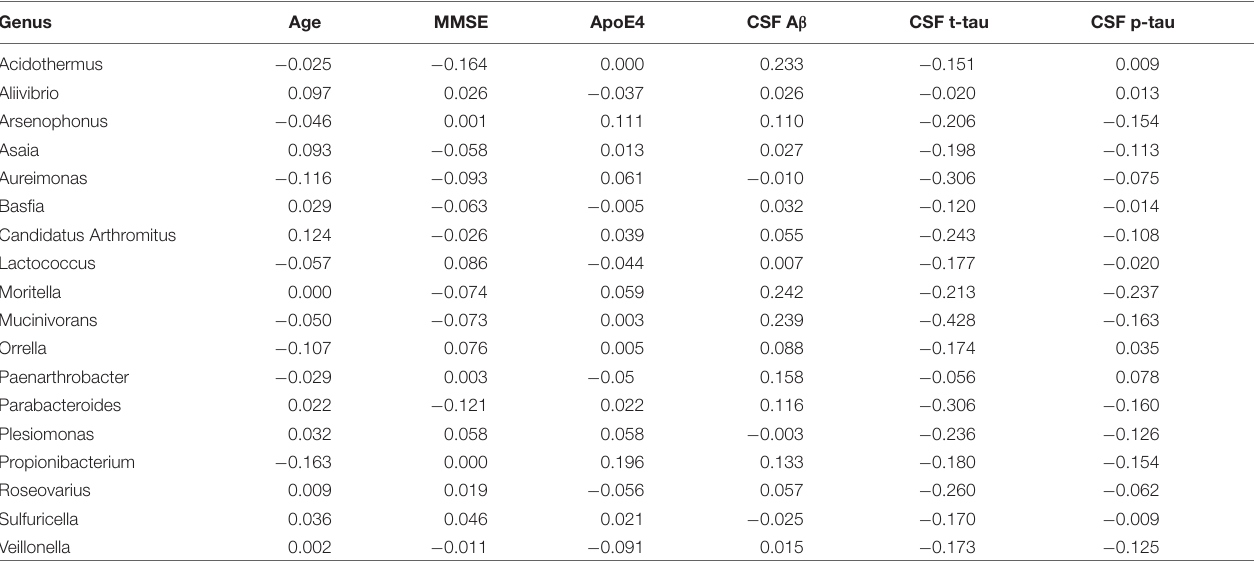
TABLE 5 | The associations between genera and Alzheimer’s disease (AD) clinical and biomarker characteristics. Genus